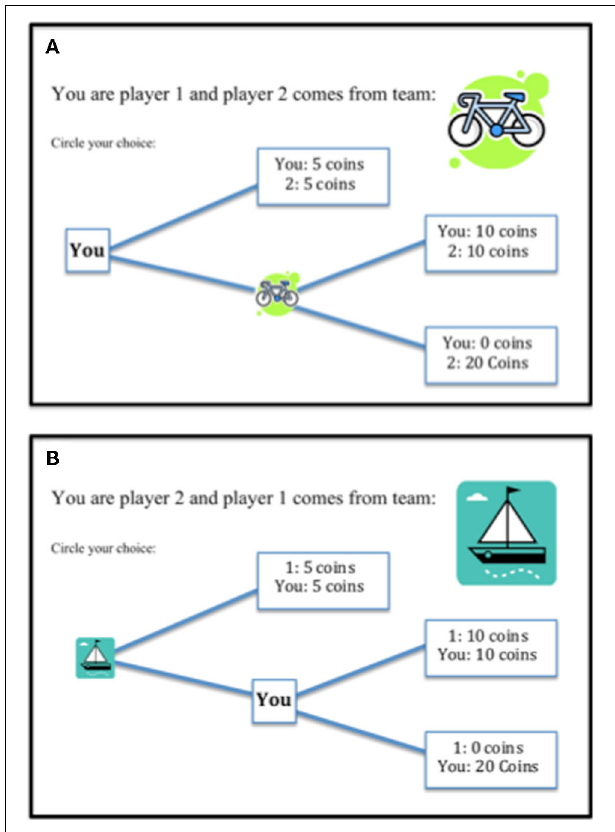
FIGURE 2 | Visual display for the Trust game. (A) Participant is the investor (here “you”), the interaction partner is the trustee (here group “boot”). (B) Participant is the trustee (here “you”), the interaction partner is the investor (here group